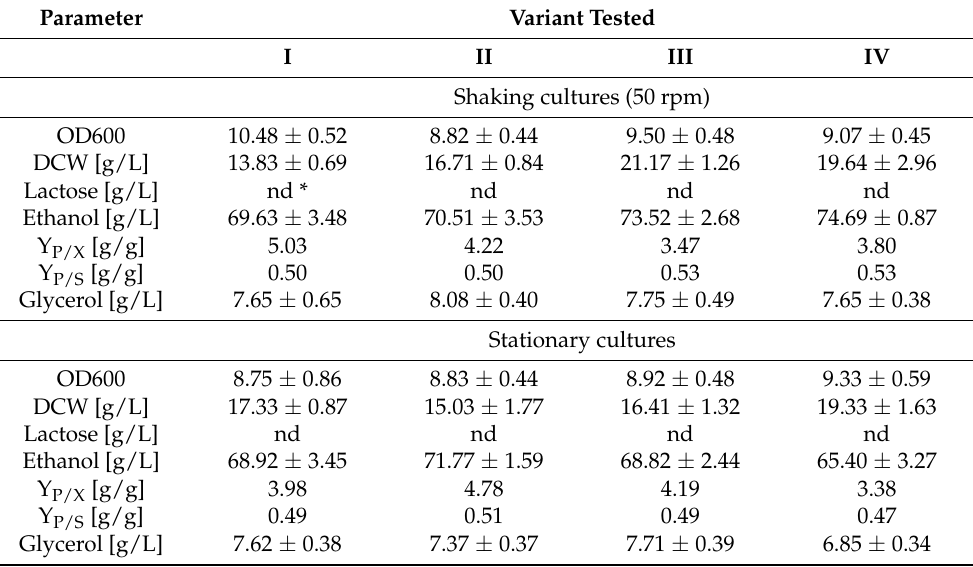
Table 3. Parameters of 72 h batch cultures of K. marxianus WUT240 in WP200 medium at 30 ◦ C. Analyses were performed in duplicate and data are presented as the mean ± SD.